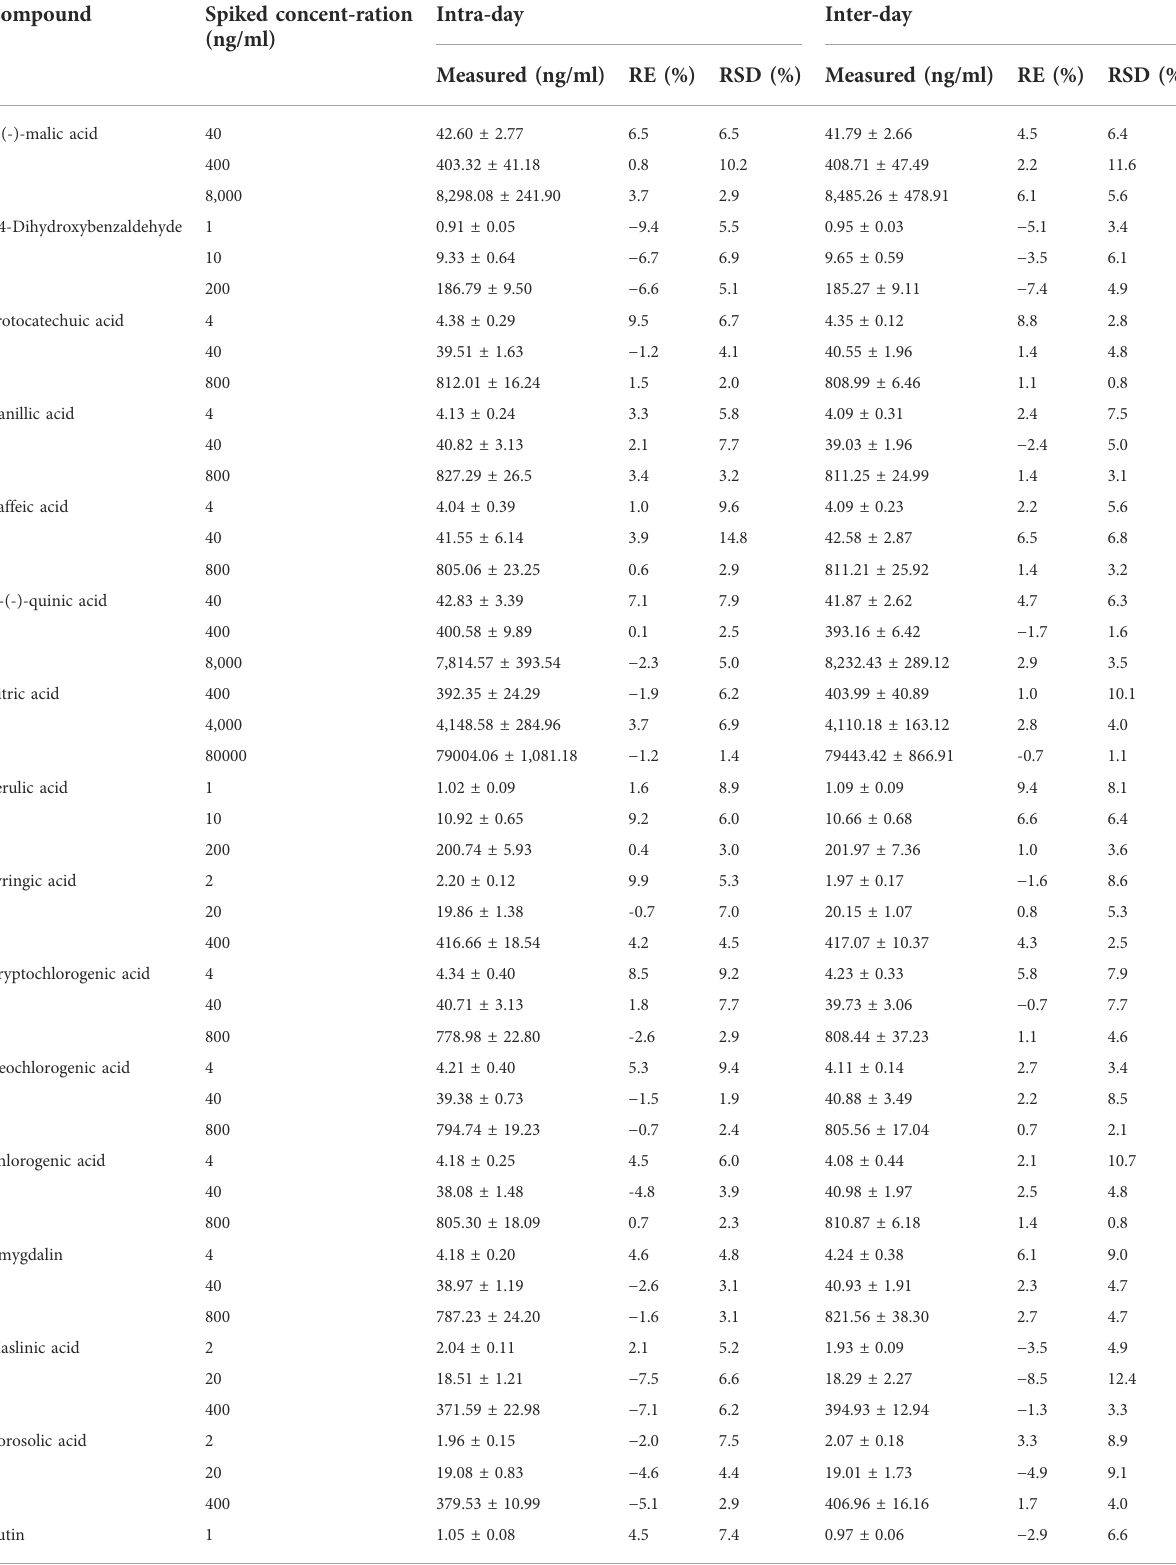
TABLE 2 Precision and accuracy of 16 analytes in rat plasma ( n = 6).